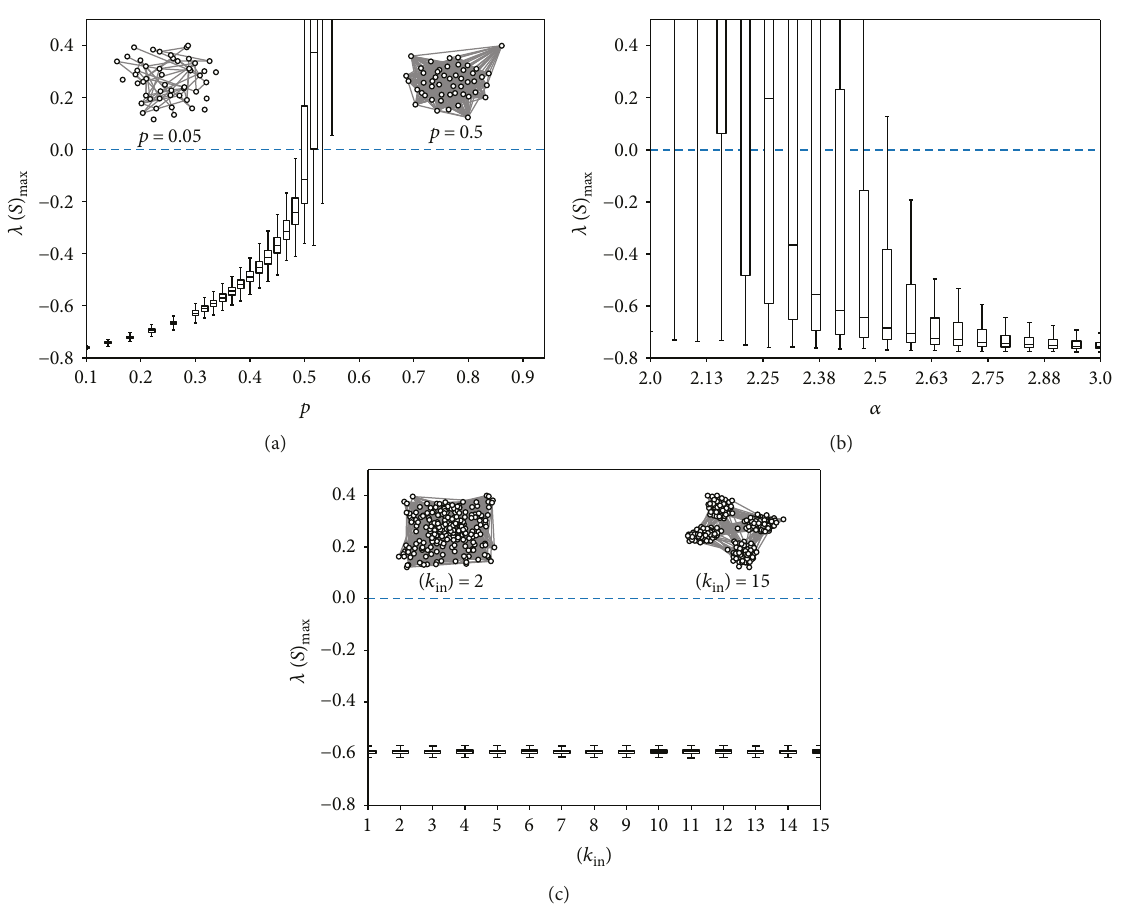
fi ned in (22), for di ff erent values of the characteristic parameter of the network: edge probability p for Figure 6: Set of boxplots of λ S max , de an Erdös-Rényi network of size N = 50 (a), degree distribution exponent α for a heterogeneous network of size N = 200 (b), and intramodule degree k in for a Newman modular network of size N = 256 and k total = 16 (c). Metric state is given by (8) and it is stable only if λ S max < 0 (dashed blue line). For each value of μ ,we make 1000 realization of the corresponding network class, each one representing one single individual, to capture the distribution of the maximum eigenvalue of matrix S . Edge probability, p , of an Erdös-Rényi network makes for a narrower threshold of stability than α exponent of a heterogeneous network. Conversely, k in parameter of the Newman modular network does not lead to any change in stability. Parameters of the model are set for all nodes to C = 5 and K = 1 for all networks, r = 1 and w = 0 03 for Erdös-Rényi network, r = 0 5 and w = 0 025 for heterogeneous network, and r = 0 05 and w = 0 015 for Newman modular